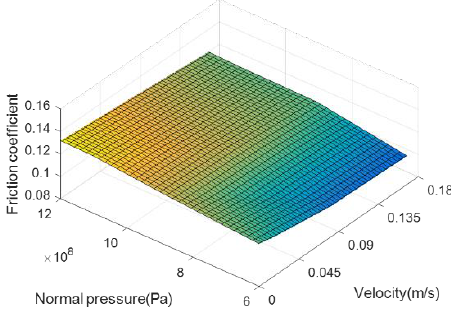
Figure 5. Pure sliding friction coefficient between spherical roller and track.